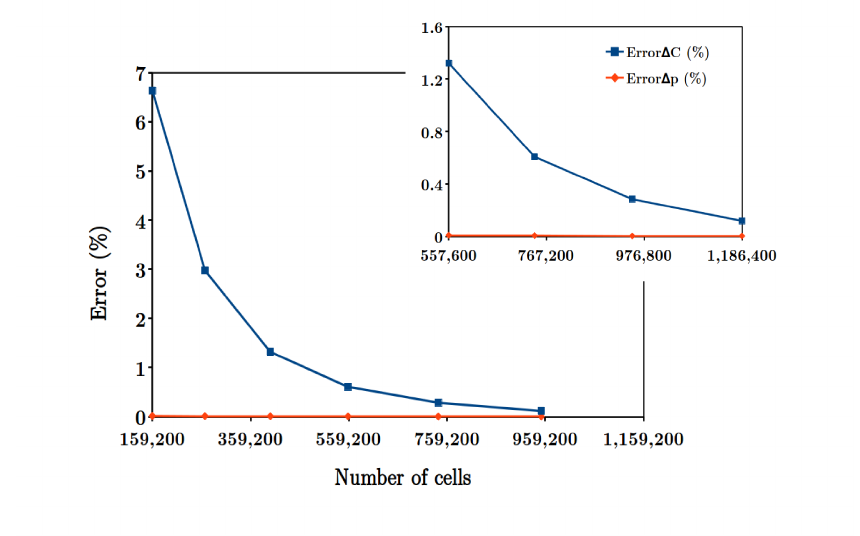
Figure 9. Numerical errors for the concentration difference and pressure drop between inlet and outlet of cylindrical active spacer-filled